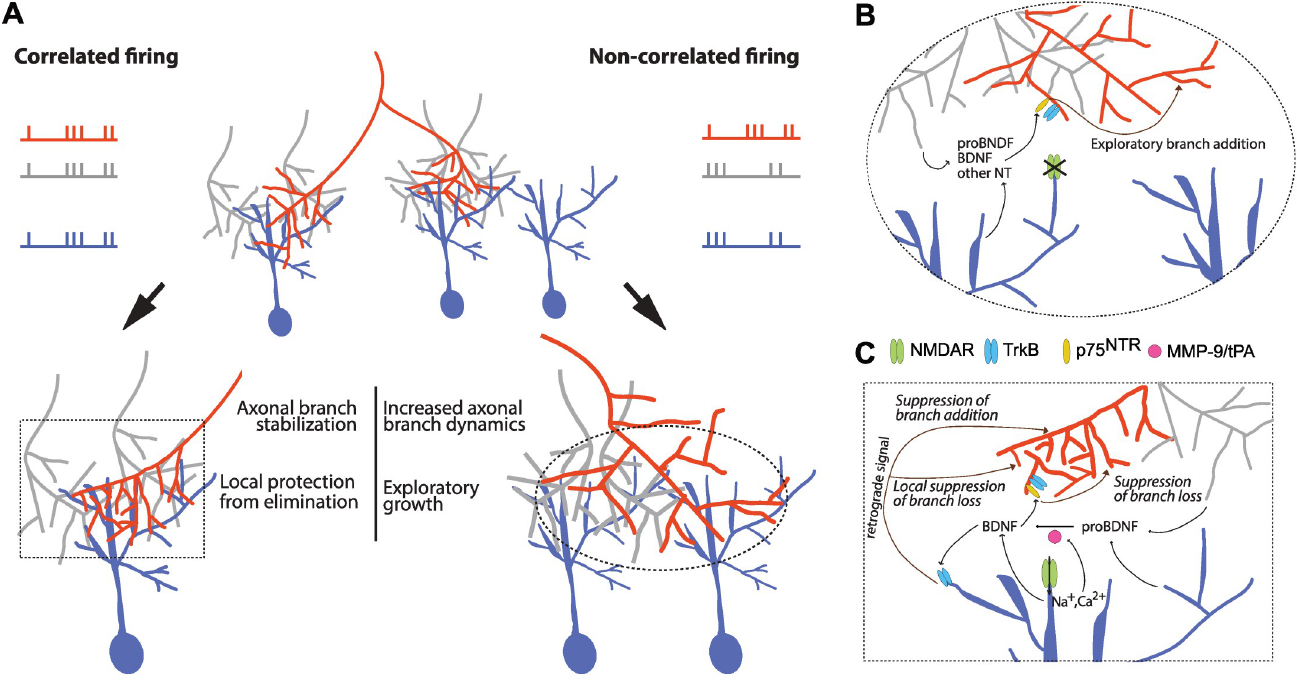
Fig 5. Proposed model of BDNF signaling in correlation-dependent structural remodeling. (A) Summary schematic of structural remodeling of an RGC axon of interest (red) instructed by patterned activity based on our current and previous studies: correlated firing (left) and non-correlated firing (right) of axon with neighboring inputs and postsynaptic partner. In conditions of poorly correlated firing, there is an increase in branch dynamics (addition and loss) and exploratory growth. Correlated firing results in a decrease in branch dynamics addition and loss, occurring within part of the axonal arbor. Protection against branch elimination occurs locally in parts of the arbor, strongly connected to tectal neurons (blue) via synapses in which postsynaptic NMDARs are strongly activated. Zoom-in of proposed molecular and cellular mechanisms underlying (B) Stentian and (C) Hebbian structural plasticity in the developing visual system. (B) Uncorrelated firing between an RGC axon (red) and its neighboring axons (gray), leads to a failure to activate postsynaptic NMDARs. A signal that promotes branch initiation and growth binds to p75 NTR on the axon of interest (red) may be released by the neighboring axons (gray) or the postsynaptic partner (blue). We propose that this signal may be proBDNF. (C) Correlated firing of the RGC axon of interest (red) and its neighboring axons (gray) results in an activation of postsynaptic NMDARs, leading to an increase in the concentration of BDNF via release or cleavage of proBDNF (e.g., via MMP-9 or tPA). BDNF binds to postsynaptic TrkB that initiates a retrograde stabilization signal (of unknown identity) leading to suppression of branch addition and targeted decrease of branch loss. BDNF, brain-derived neurotrophic factor; MMP-9, Matrix metalloproteinase-9; NMDAR, N-methyl-D-aspartate receptor; NT, neurotrophin; RGC, retinal ganglion cell; tPA, tissue plasminogen